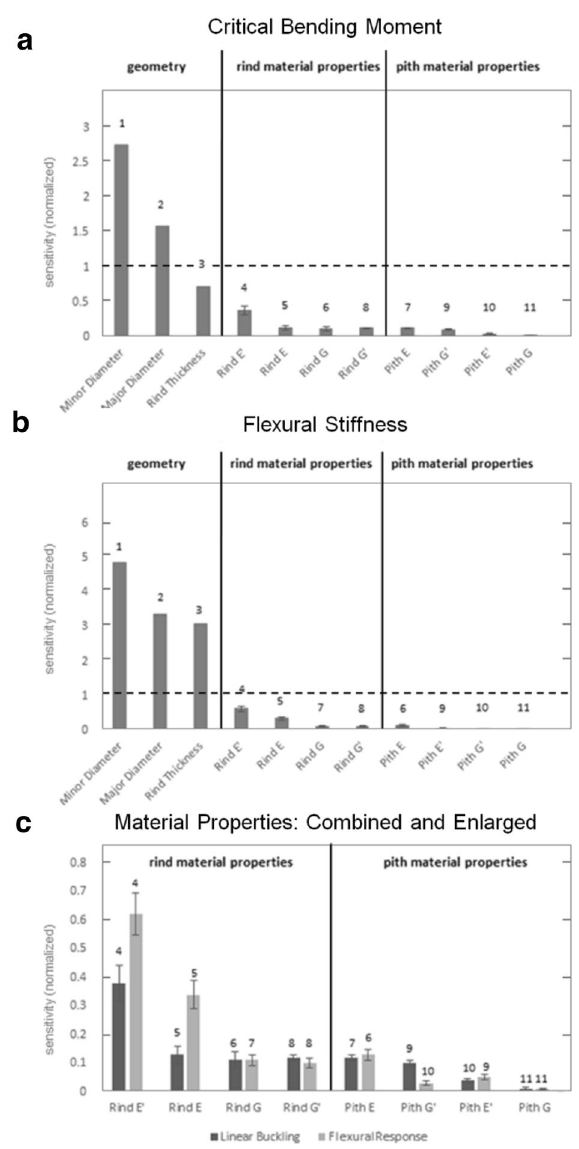
Figure 6. Normalized sensitivities (% change in output / % change in parameter) of geometric and material parameters. ( a )—linear buckling ( b )—flexural stiffness. Panel ( c ) contains both results, and is enlarged to show the results of material parameters only. Whiskers represent 95% confidence intervals on the means. The numeral above each bar indicates that parameter’s ordinal